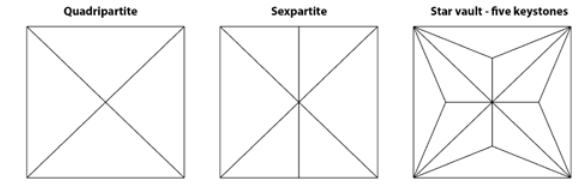
Figure 2 . Ribbed Vaults classification